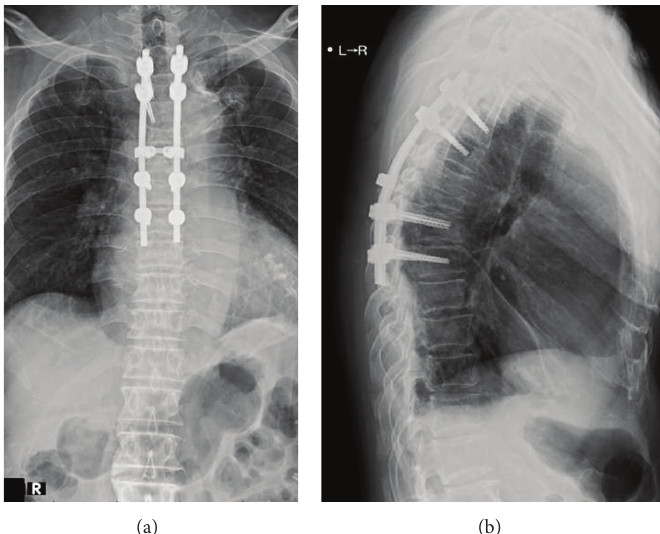
Figure 3: (a) Anteroposterior and (b) lateral radiographs show T3–8 posterior spinal segmental instrumentation and fusion.